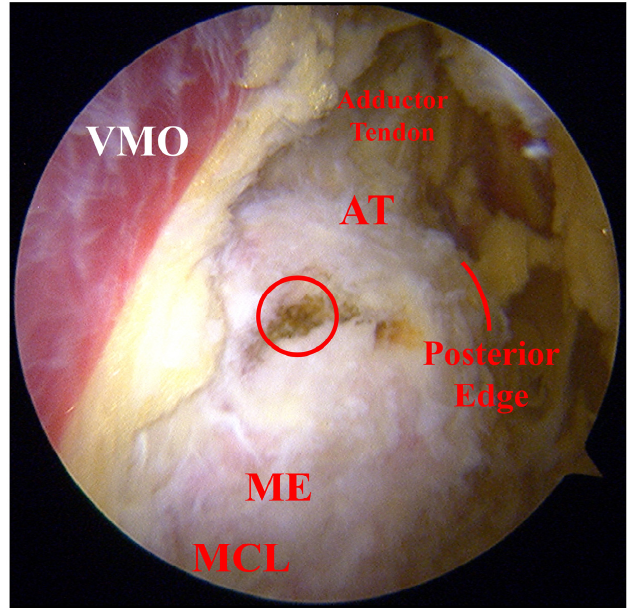
Figure 5. The relative position between the femoral tunnel (red circle) marked with cauterization and main anatomic landmarks under arthroscope. AT, adductor tubercle. MCL, medial collateral ligament. ME, medial epicondyle. VMO, vastus medialis oblique.